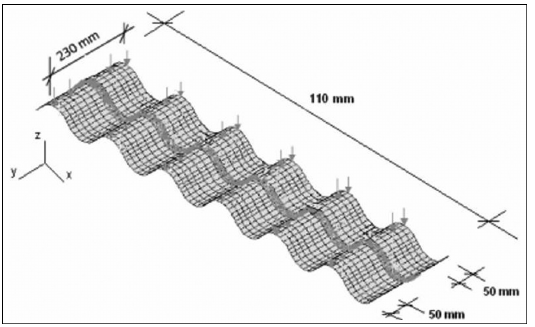
Figure 6. Fractions of load applied in line, in the high waves 2, 4, 6, 8, 10 and 12, in the central area of width 230 mm to the 50 mm of the extremities of cleaver.